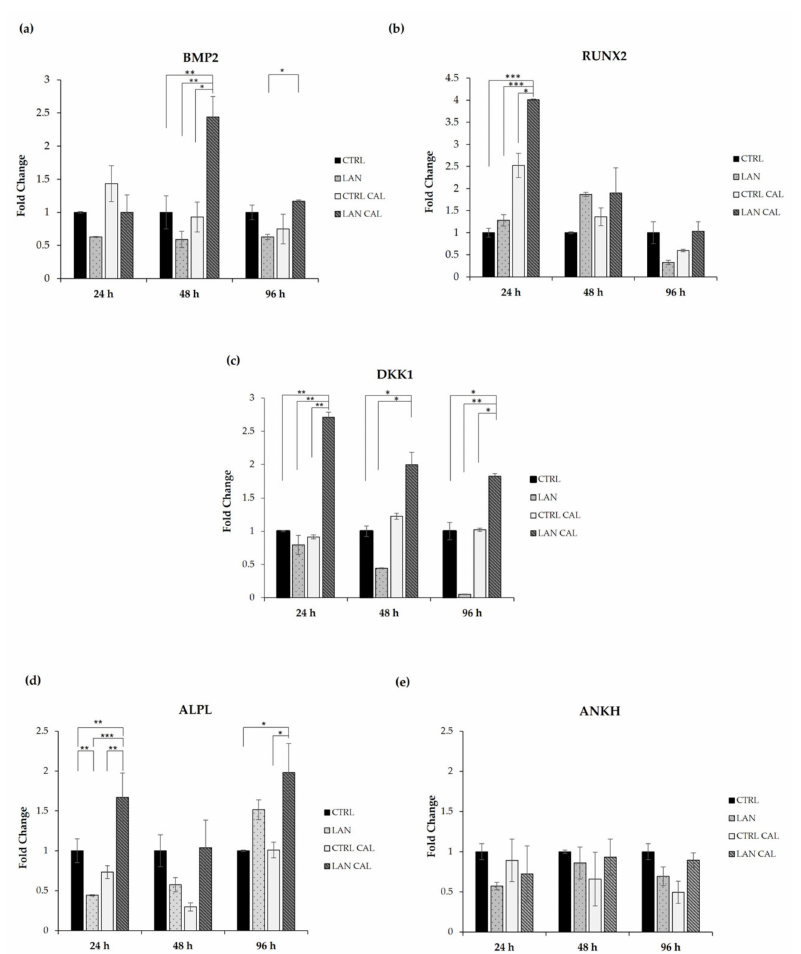
Figure 3. The effect of lanthionine on the expression of genes involved in the earliest phase of the mineralization process in EA.hy926 cell cultures. The relative expression levels of the genes, ( a ) BMP2 ; ( b ) RUNX2 ; ( c ) DKK1 ; ( d ) ALPL ; ( e ) ANKH , using qPCR after 24 h, 48 h and 96 h of treatment, in comparison to the untreated control, are shown as a bar equal to 1: The columns represent the mean and error bars indicating the SD from three independent experiments; p -value versus the untreated control = * p < 0.05, ** p < 0.01; *** p < 0.001 (according to the Anova test). BMP2 , Bone morphogenetic protein 2; RUNX2 , Runt-related transcription factor 2; DKK1 , Dickkopf WNT Signaling